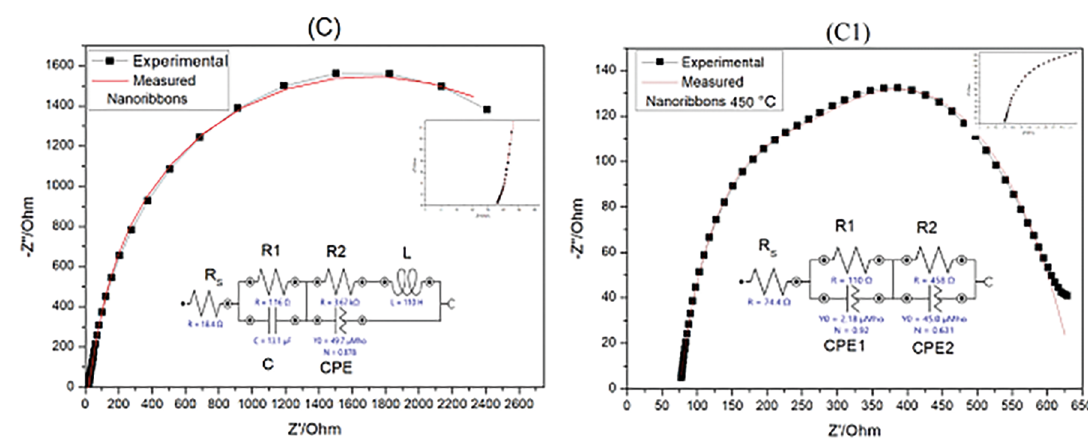
Figure 7. Nyquist diagrams of the cells with (C) Nanoribbons and (C1) Nanoribbons-450